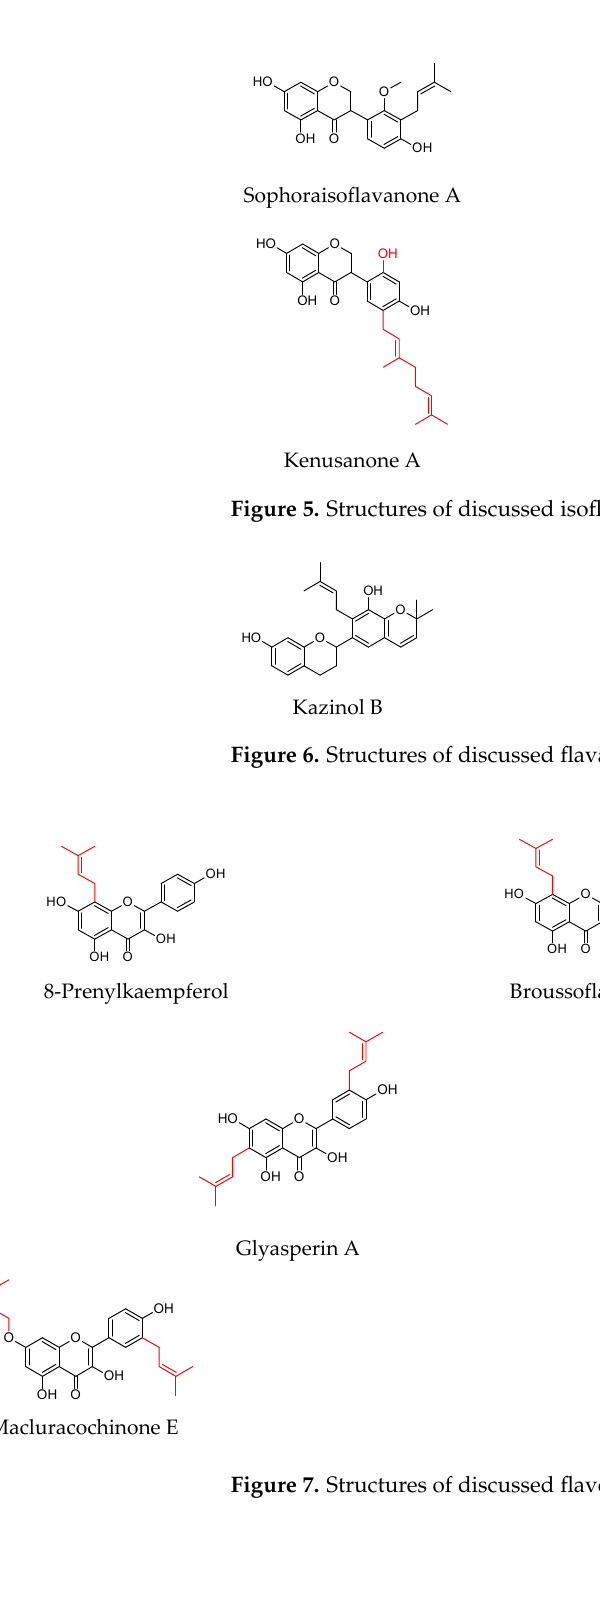
Figure 4. Structures of discussed flavanonols.